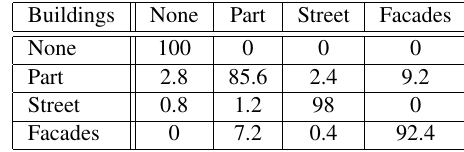
Table 1: Confusion matrix for the scene classification